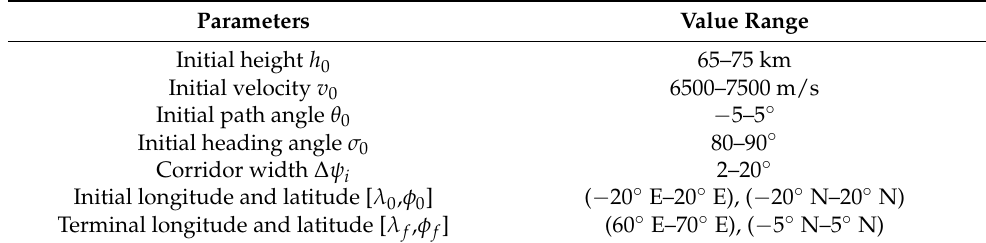
Table 1. Simulation initial conditions for generating dataset.